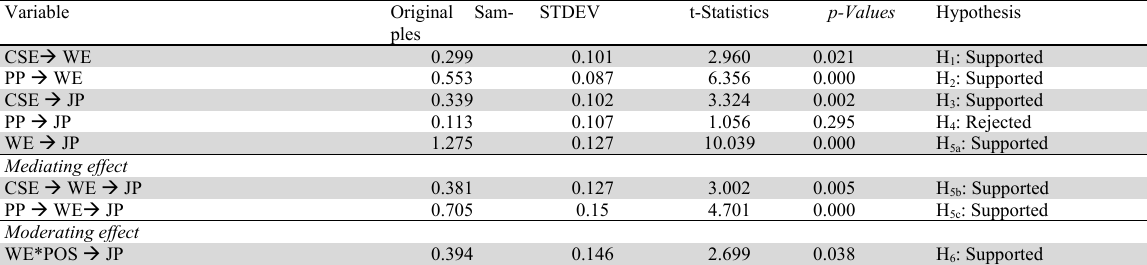
Structural Model